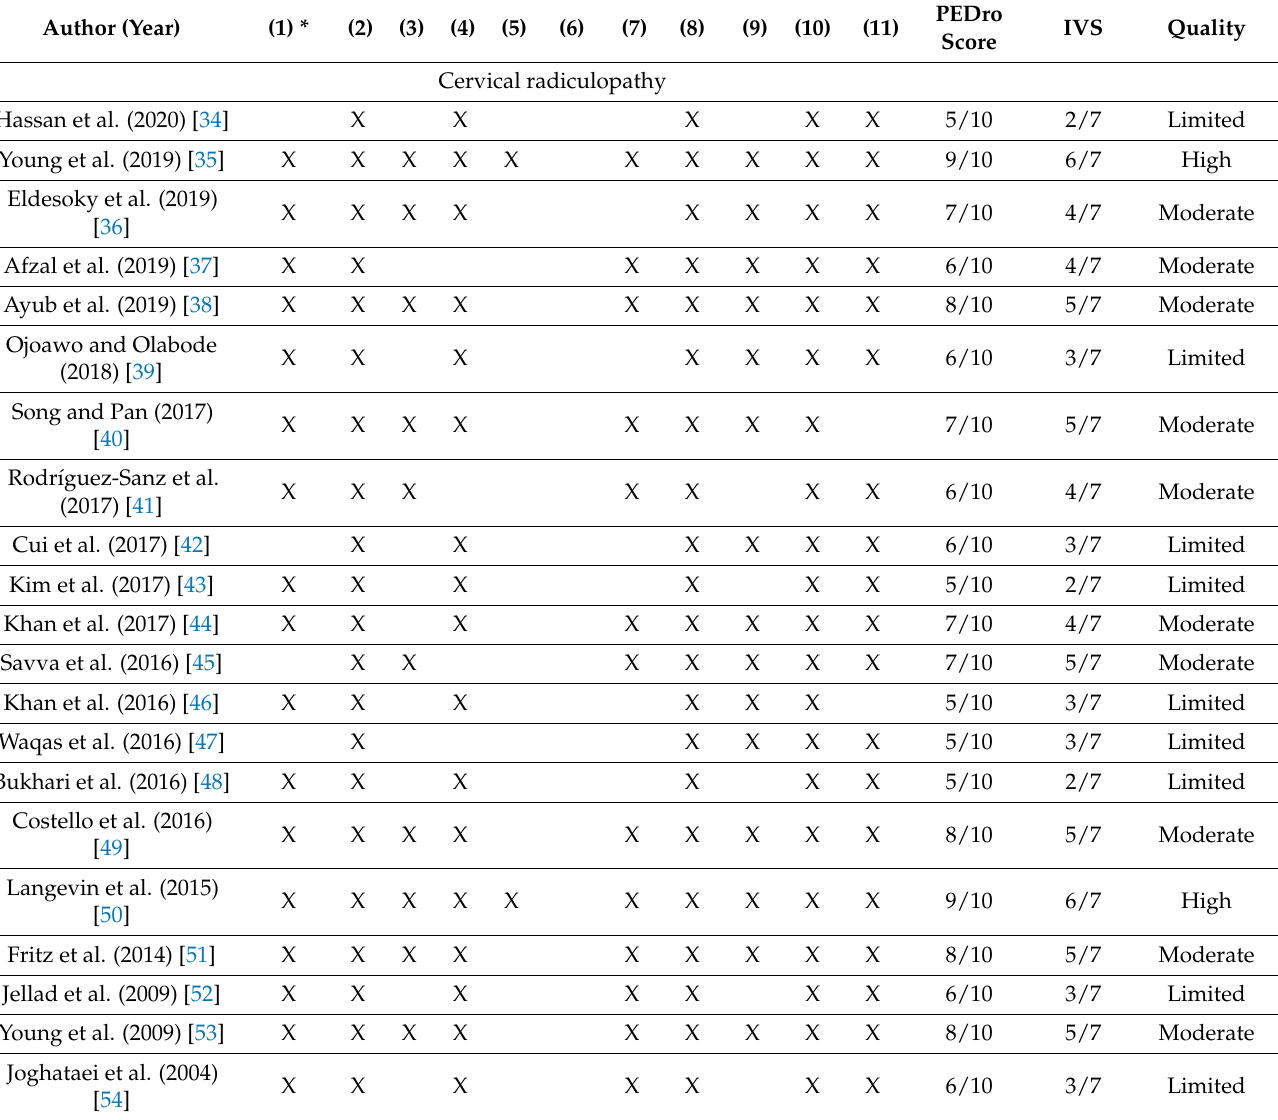
Table 1. Methodological quality of the included